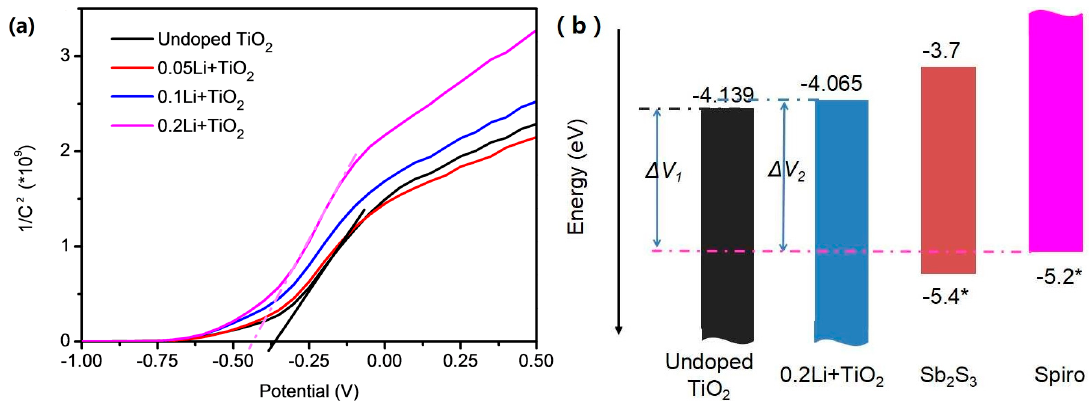
Figure 6. ( a ) Mott–Schottky curves of the mesoporous TiO 2 varying with Li-doping. ( b ) Energy band scheme [32].